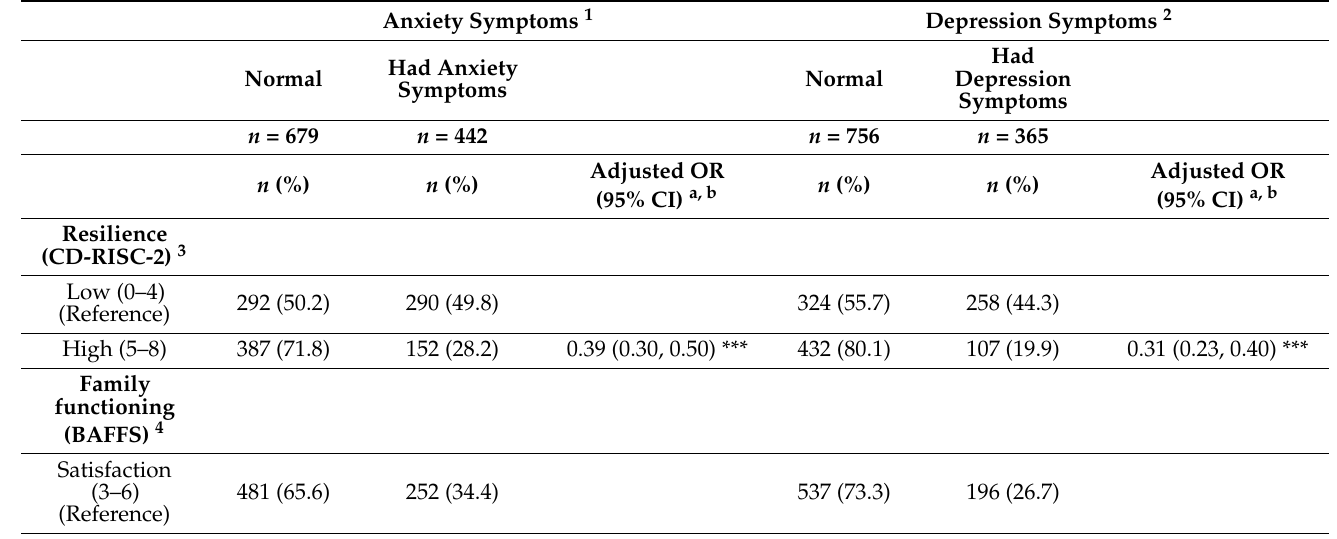
Table 3. Associations of mental health with the level of resilience, family functioning and support system. Anxiety Symptoms